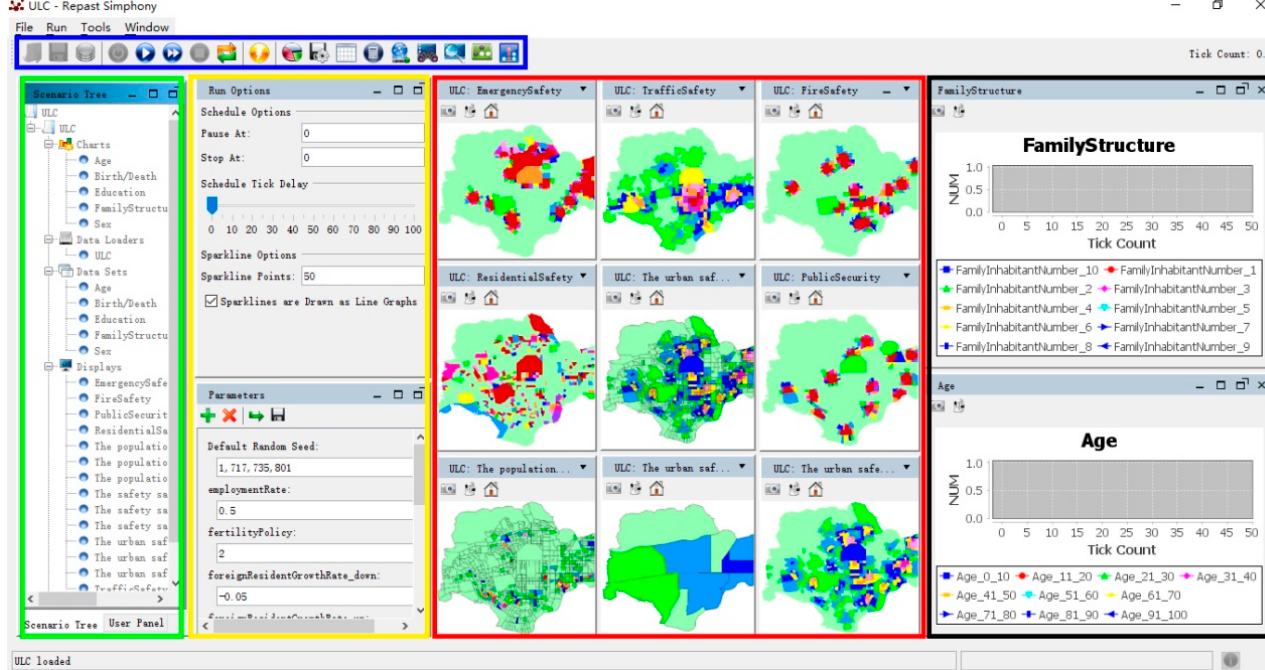
Figure 9. Operational interface.